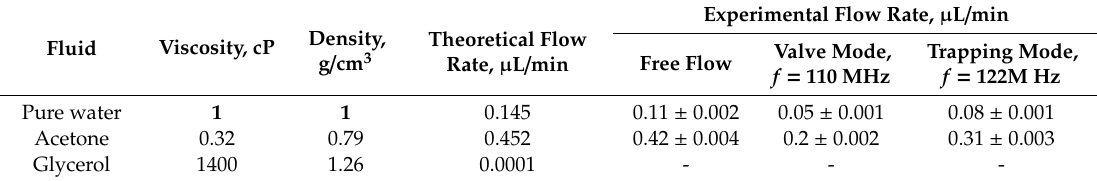
Table 3. Pressure-driven microflow of di ff erent